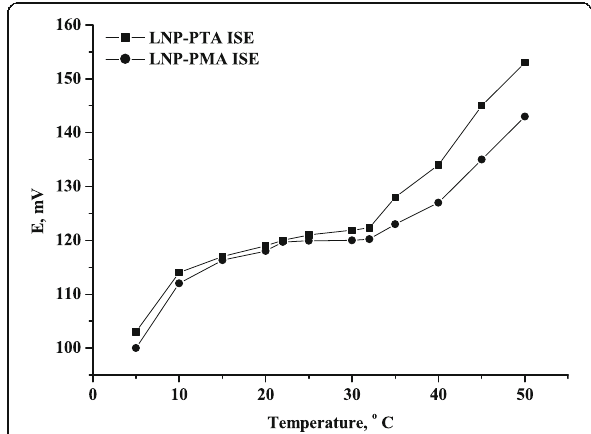
Fig. 5 Effect of soaking time on potential of 5.0 × 10 − 4 mmol l − 1 LNP for LNP-PTA and LNP-PMA ISEs